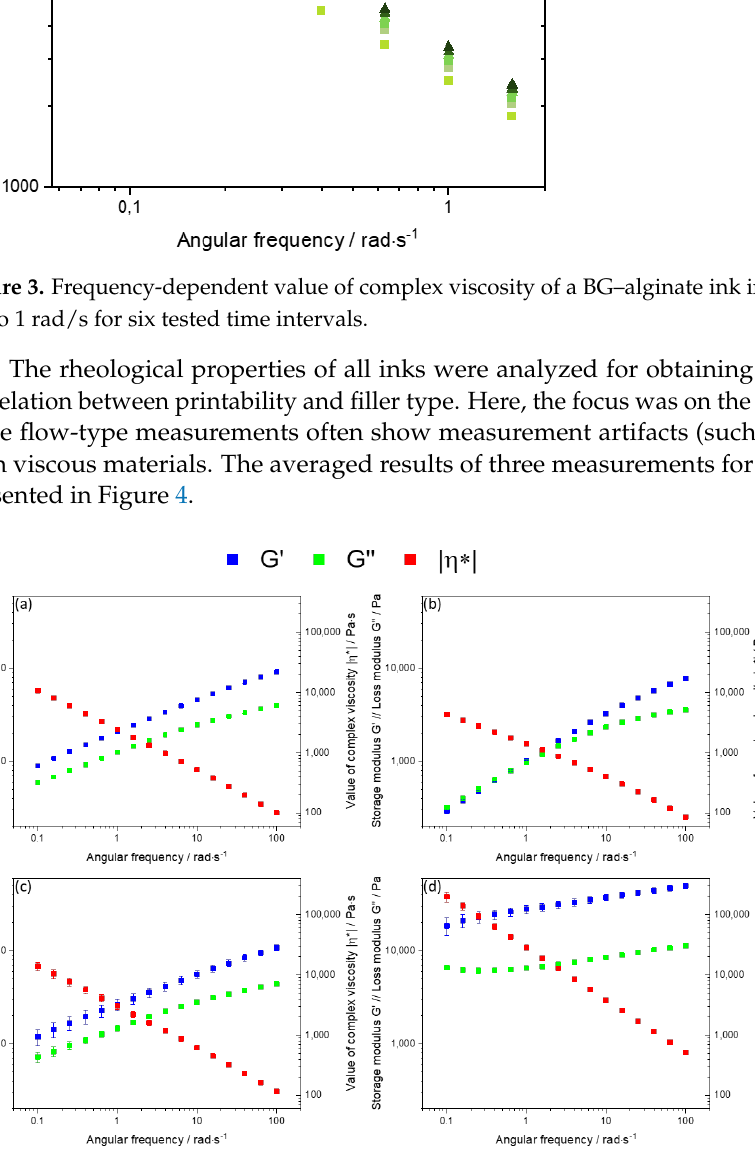
Figure 4. Frequency-sweeps of the tested alginate matrix inks with different fillers; ( a ): angular inert glass, ( b ): round inert glass, ( c ): angular BG, ( d ): round HA. The green and blue graphs represent the loss (G’’) and storage (G’) moduli. The value of complex viscosity is highlighted in red. A major difference between the tested compo- sites is evident: the sample containing rIG filler shows similar values for G’ and G’’ in the low frequency regime with a crossover point at about 1 rad/s. From this point, G’ starts to dominate the viscoelastic material behavior. The value of complex viscosity also shows a slight curvature, hinting towards a more liquid-like material behavior, especially in the low frequency regime. This is not observable for the three other composite inks. Here, G’ always dominates G’’, resulting in rheological elastic material behavior in the tested fre- quency regime. The values of complex viscosity all show power-law behavior. Furthermore, inks aIG and BG showed comparable material behavior for the storage and loss moduli as well as for the value of complex viscosity, as shown in Figure 5. In contrast, HA filler showed a significant lower influence of the angular frequency on both moduli, resembling a more pronounced gel-like character. Additionally, the value of com- plex viscosity was shifted by a factor of ten to higher values. In the field of biofabrication, a high value of complex viscosity at low frequencies usually positively influences the shape fidelity [39,40]. Additionally, a rheological solid material behavior reduces strand spreading and improves stackability. Therefore, a prediction of printing shape fidelity from the rheological measurement data results in the following order (from most suitable to deficient): HA > BG = aIG > rIG It has to be mentioned that the presented prediction is only based on the rheological characterization. Other relevant attributes, such as homogeneity of extrusion and nozzle clogging, are not considered and may alter the actual applicability of the inks.